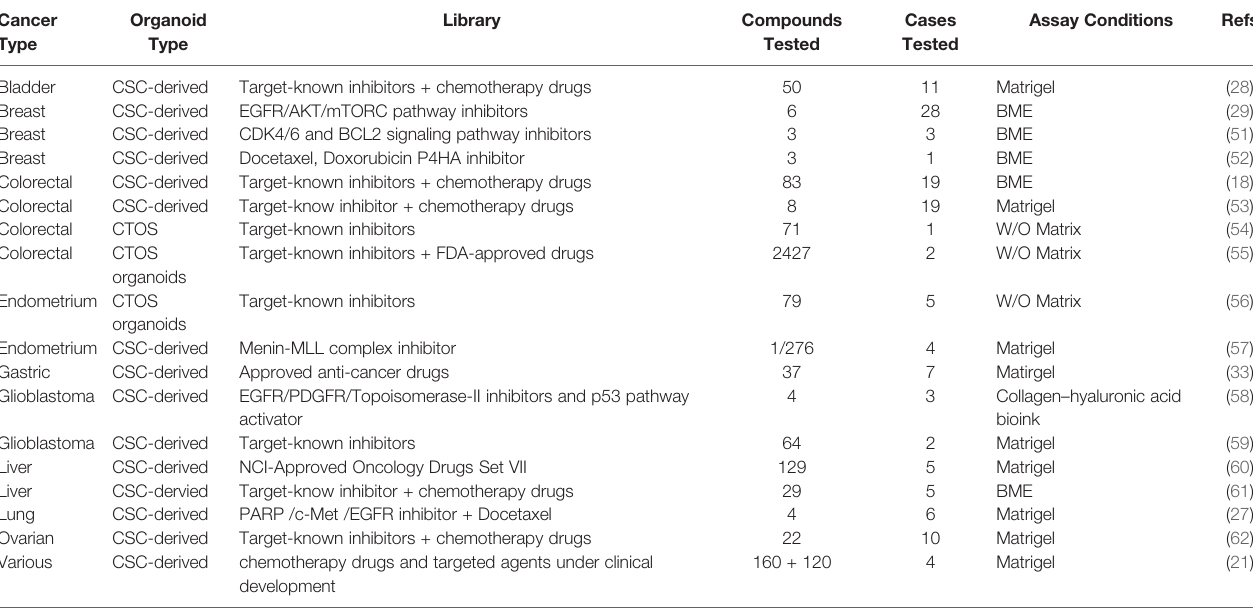
TABLE 1 | Application of drug screening with organoid culture platforms. Cancer